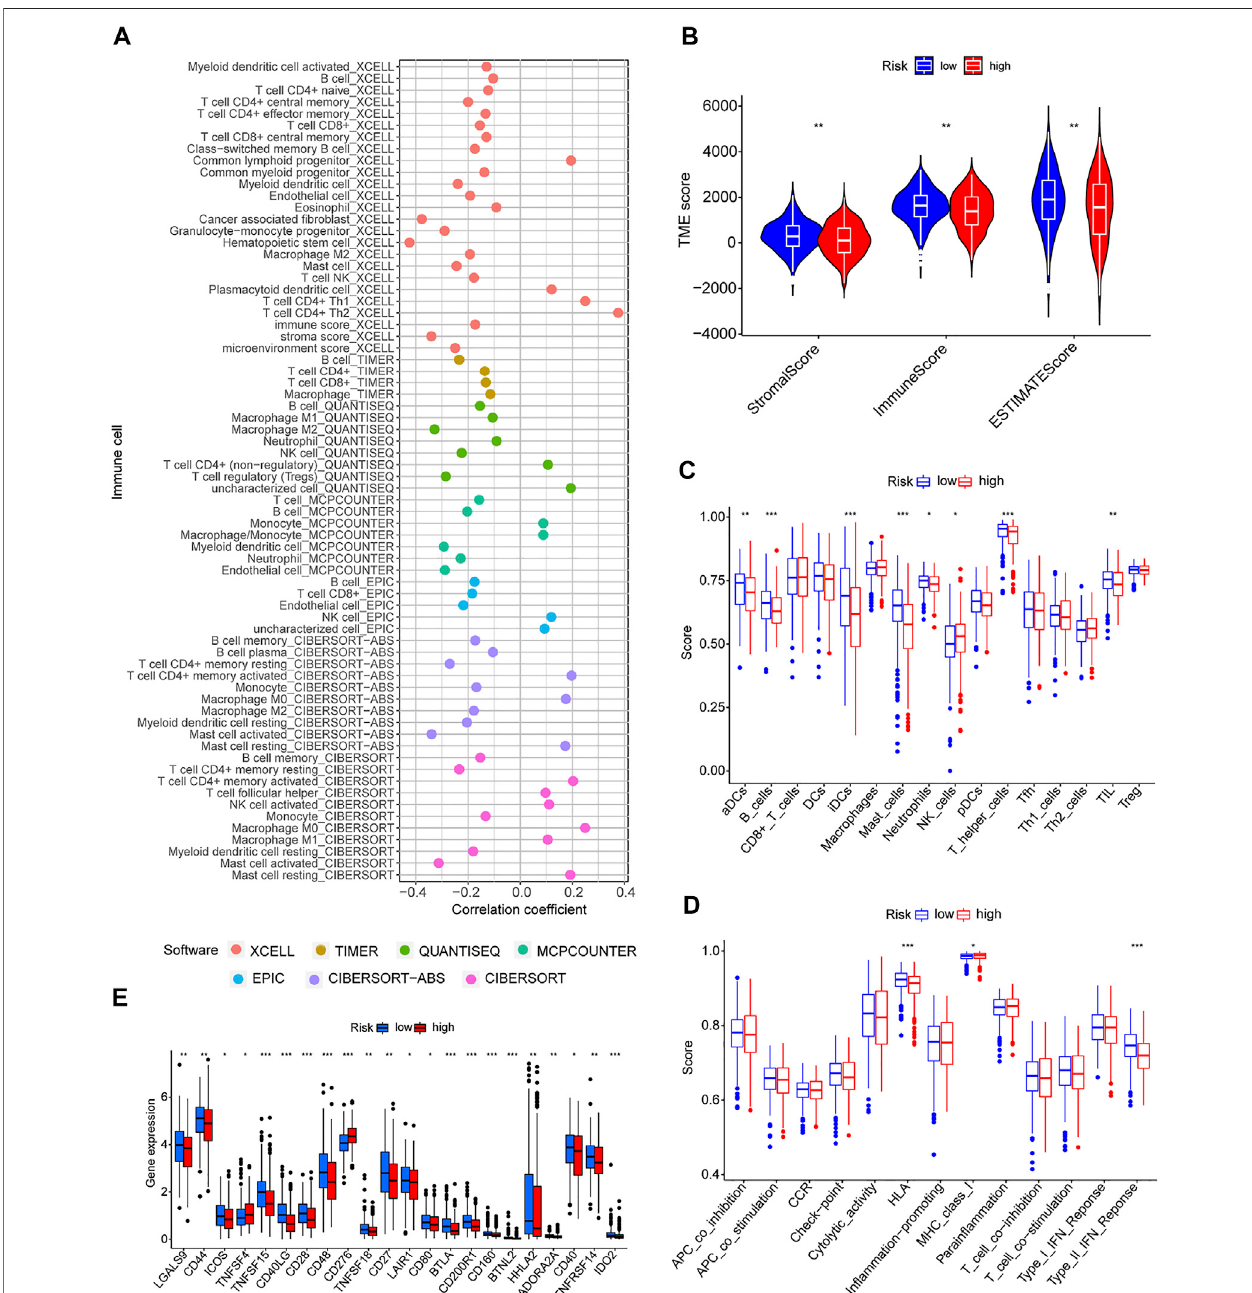
FIGURE7| Immunesignaturesofdifferentrisk groups. (A) Correlationbetweenriskscoresand immunecells. (B) Comparison ofimmune-related scoresbetween low-risk and high-risk groups. (C,D) Enrichment scores for 16 immune cells and 13 immune-related pathways. (E) Differences in the expression of 22 checkpoints in different risk groups. * p < 0.05, ** p < 0.01, *** p < 0.001.